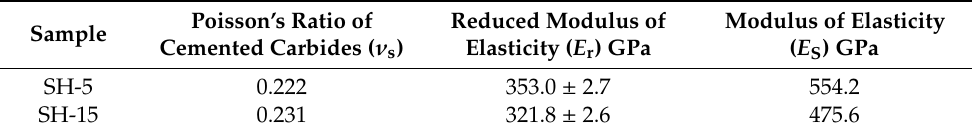
Table 9. Young’s modulus of